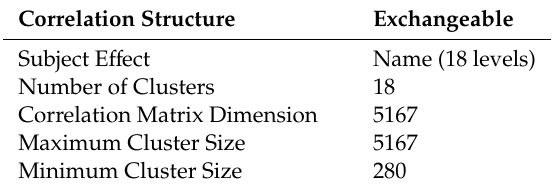
Table 1. Generalized estimating equations (GEE) model information (Algorithm converged).